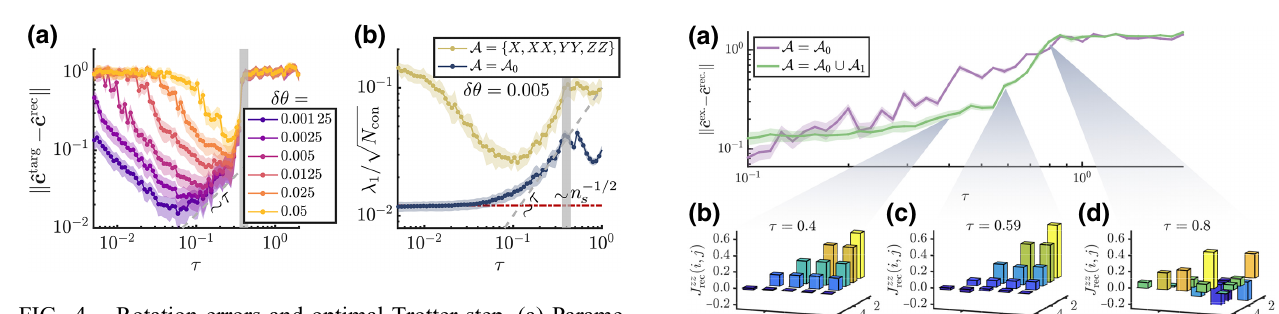
FIG. 4. Rotation errors and optimal Trotter step. (a) Parame- ter distance (cid:8)ˆ c targ − ˆ c rec (cid:8) . Different colors correspond to different strengths δθ of the rotation errors. Here, ˆ c rec and ˆ c targ are nor- malized to 1. The dip in (cid:8)ˆ c targ. − ˆ c rec (cid:8) , which can be used to estimate the optimal τ for the DQS in the presence of rotation errors. (b) Log-log plot of λ 1 versus τ for an ansatz encompassing the target Hamiltonian (14) (yellow data) and a full zeroth-order ansatz set A 0 (blue data), which leads to scaling down to the noise threshold. The results are obtained for a system of N = 10 spins, with target couplings J x = J y = 1, J z = 0.7, B x = 0.75 in Eq. (14). Here n s = 5000. We use 55 initial product states in ran- dom bases, each evolved to six different final times up to a total simulation time of 16. The error bars stem from measurement noise and from different initial state realizations.